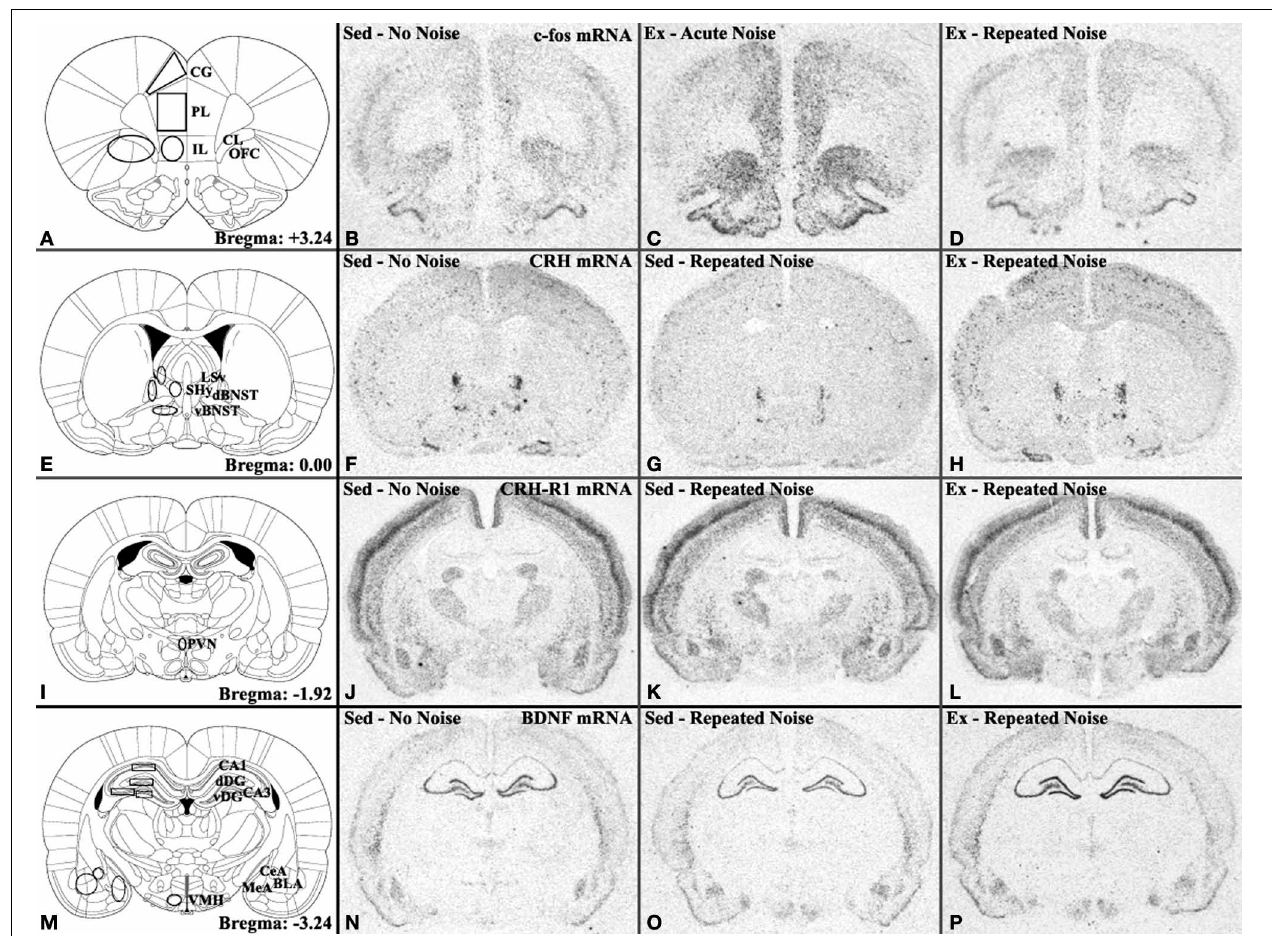
FIGURE 2 | Diagram specifying brain regions analyzed by in situ hybridization and corresponding representative autoradiograms depicting important groups differences. Panels in the left column provide images adapted from the Paxinos and Watson (2005) atlas (with permission to reprint from Elsevier) of coronal brain sections at the level of the (A) medial prefrontal cortex (mPFC), (E) ventrolateral septum (LSv) and anterior bed nucleus of the stria terminalis (BNST), (I) paraventricular nucleus of the hypothalamus (PVN), and (M) hippocampus and amygdala. All regions of interest analyzed in this study are labeled on the right sides of these sections while the left sides depict the templates used to consistently define their boundaries. Remaining panels in each row show representative autoradiogram images of specified mRNAs in brain sections corresponding to these atlas diagrams. Panels (B–D) Fos mRNA expression illustrating robust induction of Fos mRNA by acute noise stress and nearly complete habituation of Fos responses to levels similar